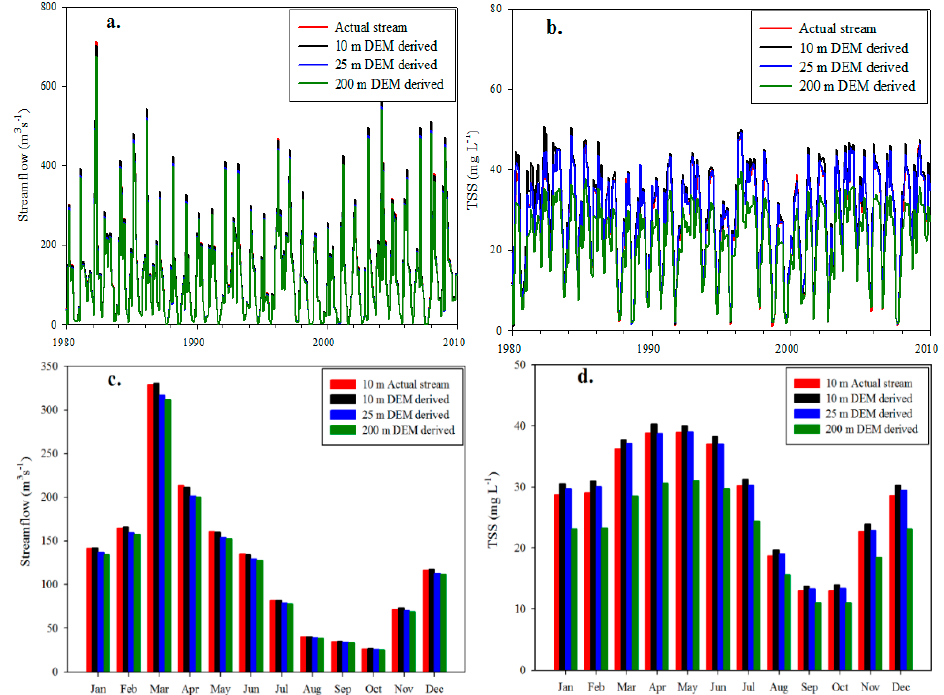
Figure 5. ( a ) Simulated stream flow (1980–2010) predicted by SWAT model using DEMs of varying resolutions, ( b ) comparison of average monthly simulated stream flow (over period 1980–2010) predicted by SWAT model using DEMs of varying resolutions, ( c ) simulated total suspended solids (1980–2010) predicted by SWAT model using DEMs of varying resolutions, ( d ) comparison of average monthly total suspended solids (over period 1980–2010) predicted by SWAT model using DEMs of varying resolutions.